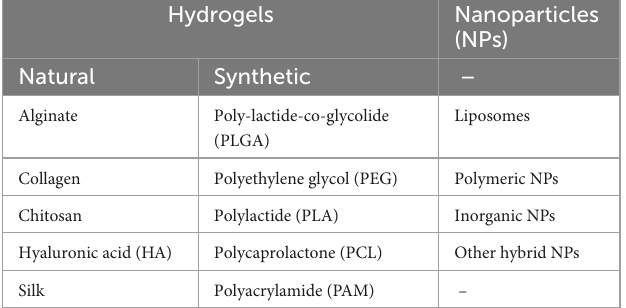
TABLE 1 Summary of different types of hydrogels and